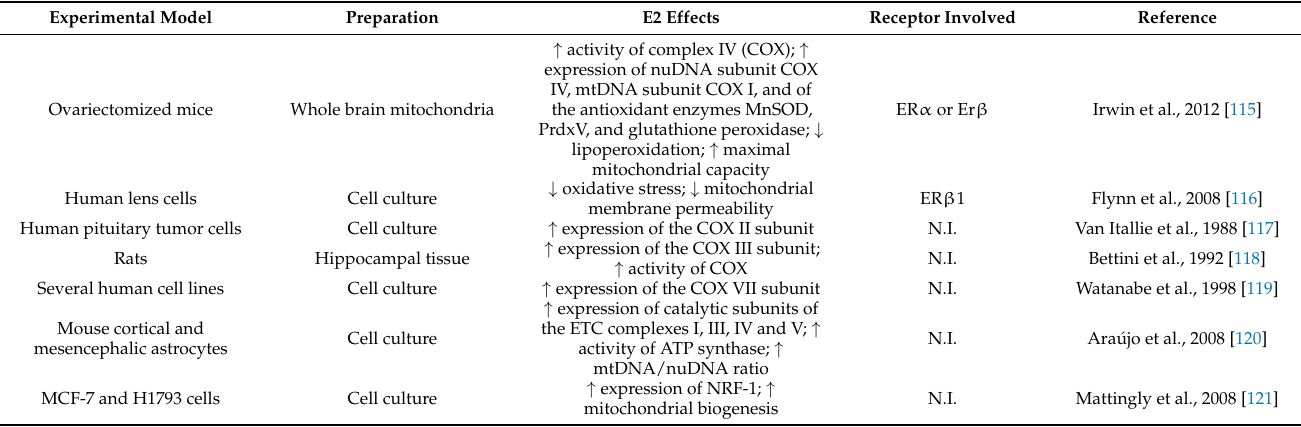
Table 1. List of studies addressing the effects of estrogen in different